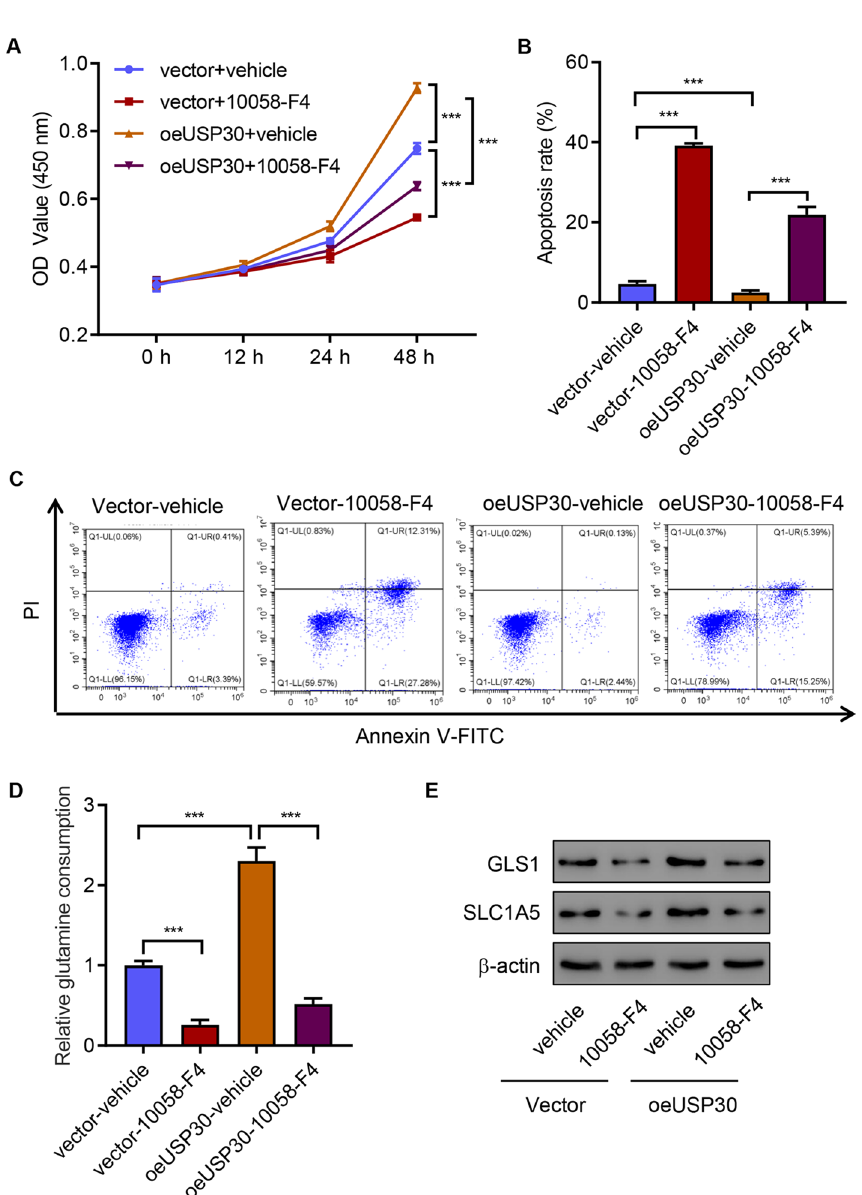
Fig. 4 USP30 overexpression promotes SCC4 cell viability and glutamine consumption, and inhibits apoptosis through upregulation of c-Myc. A Cell viability, B , C apoptosis, D glutamine consumption, and E expression of GLS1 and SLC1A5 of SCC4 cells with USP30 overexpression and c-Myc inhibitor 10,058-F4 treatment. *** P <